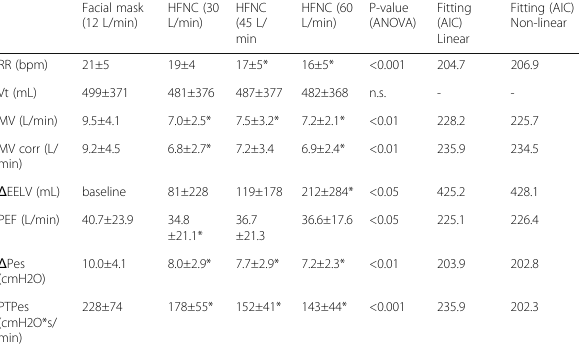
Table 108 (abstract A336). Effects of HFNC on ventilation pattern Facial mask (12